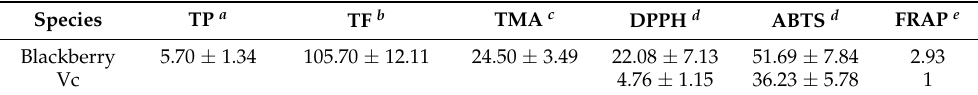
Table 2. The total phenolic contents, total flavonoid, total monomeric anthocyanin, and the antioxi- dant activities of DPPH, ABTS, and FRAP assays of